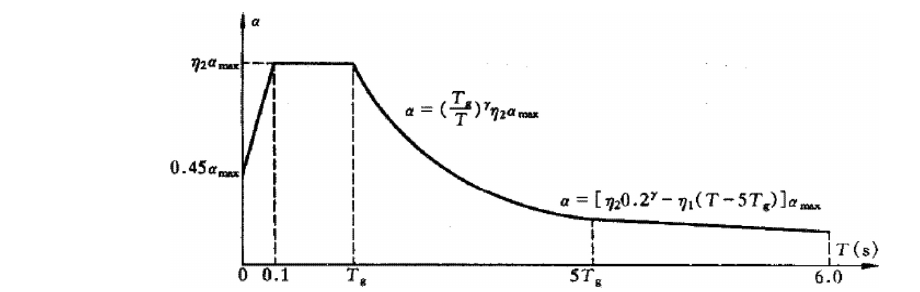
Fig. 6. Curve of acceleration response